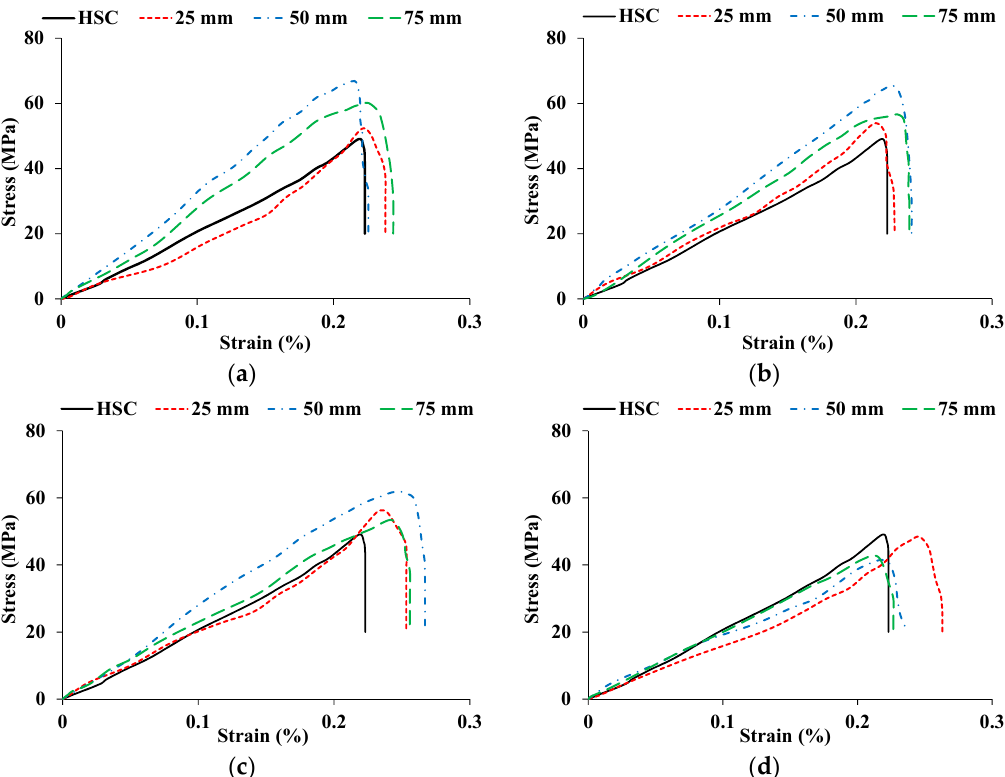
Figure 4. Stress-strain curves for HSC and CFR-HSC with ( a ) 0.5%, ( b ) 1%, ( c ) 1.5%, and ( d ) 2% fiber content.